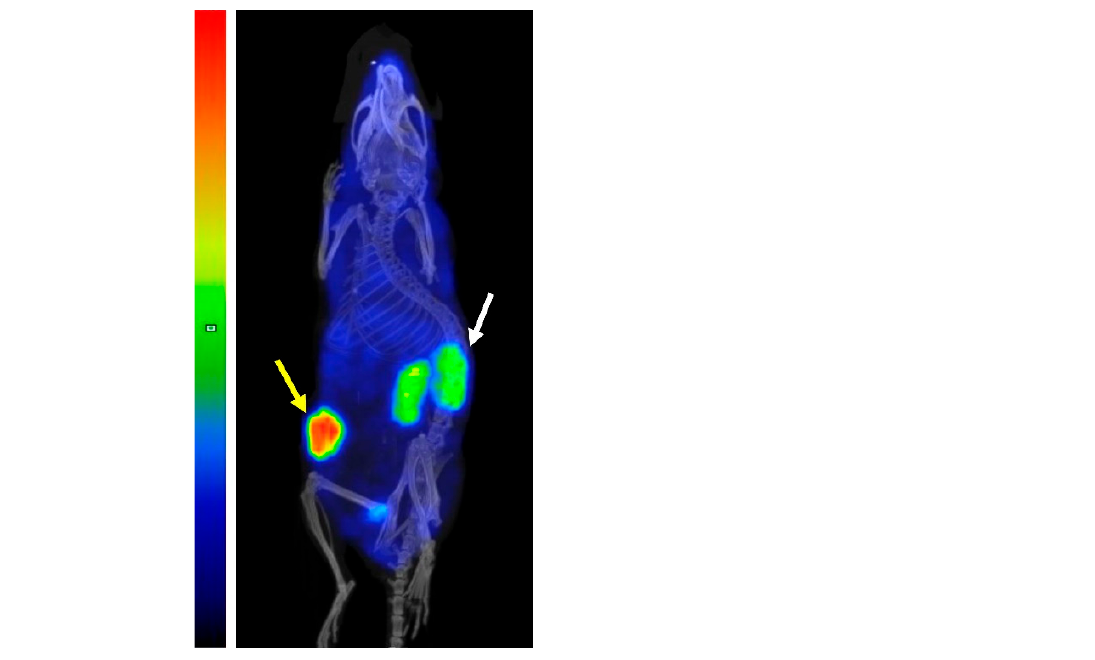
Figure 7. Imaging of mouse bearing SKOV-3 xenograft 48 h after injection of [ 177 Lu]Lu-PEP40233 using microSPECT/CT. Tumor (yellow arrow) and kidneys (white arrow) have elevated activity uptake, but tumor uptake exceeds the renal uptake. The scale is linear showing arbitrary units normalized to a maximum count rate.